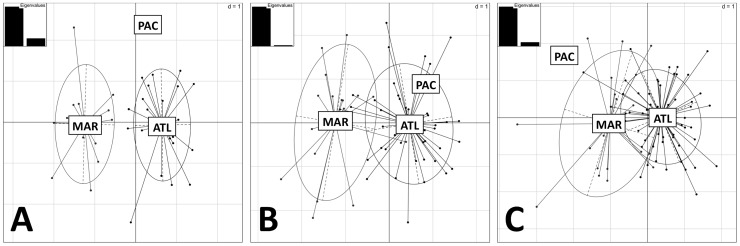
Discriminant function analysis scatterplots for skull (a), tusk (b), and mandible (c) data.Embedded is also a plot of the first two eigenvalues of the discriminant analysis. Circles encompass the range of 2/3 of the data points.